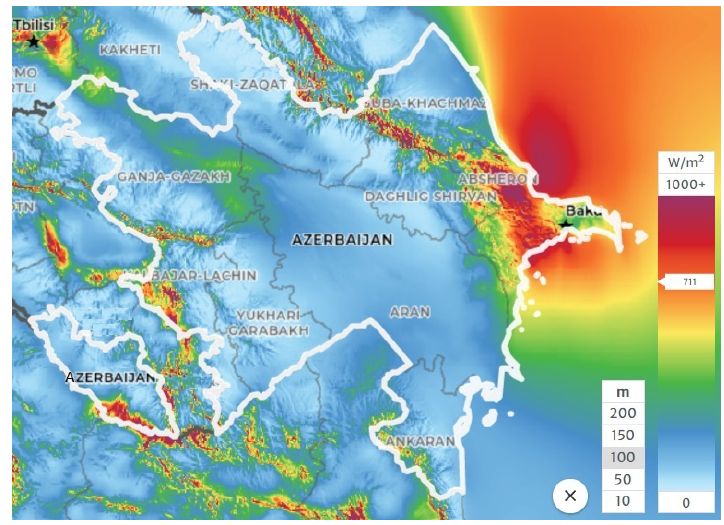
Figure 8. Mean wind speed at 100-m altitude [33].